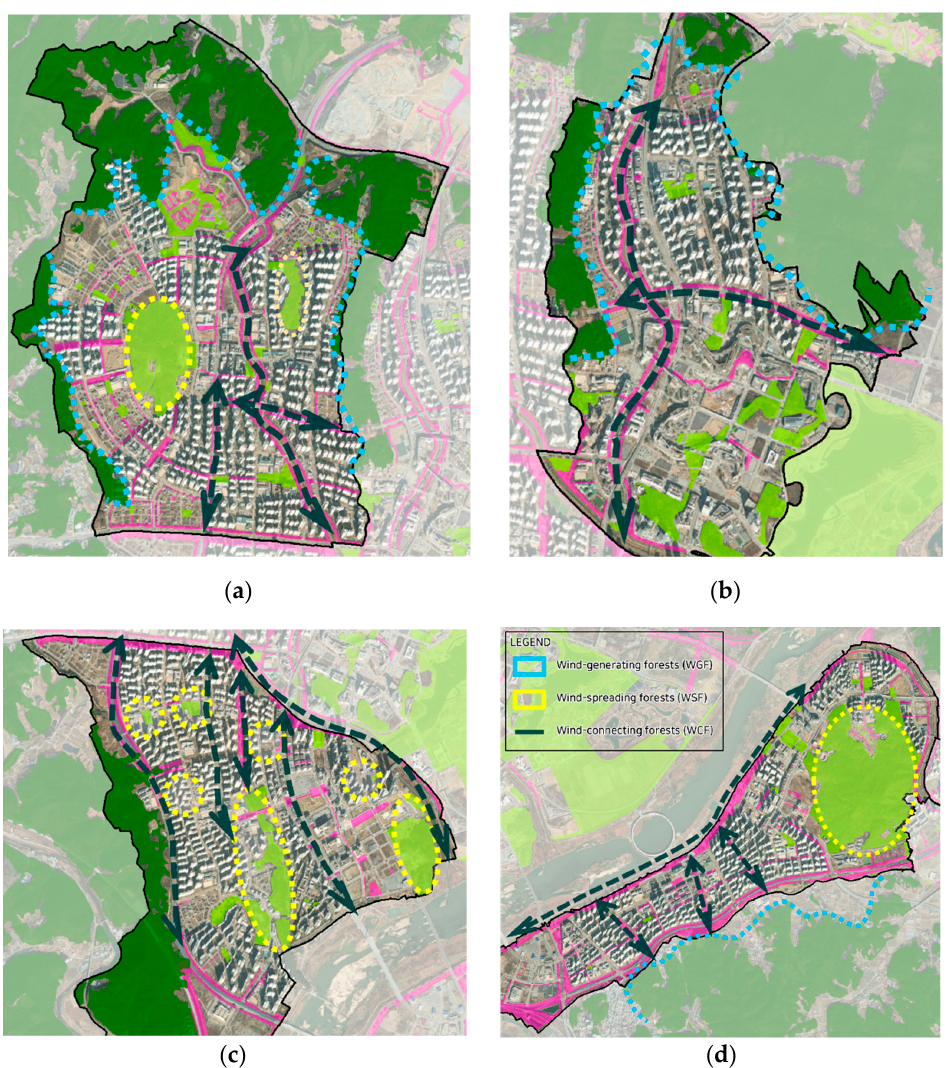
Figure 13. Division of zones for wind corridor forest implantation in HBC region based on admin- istrative districts.